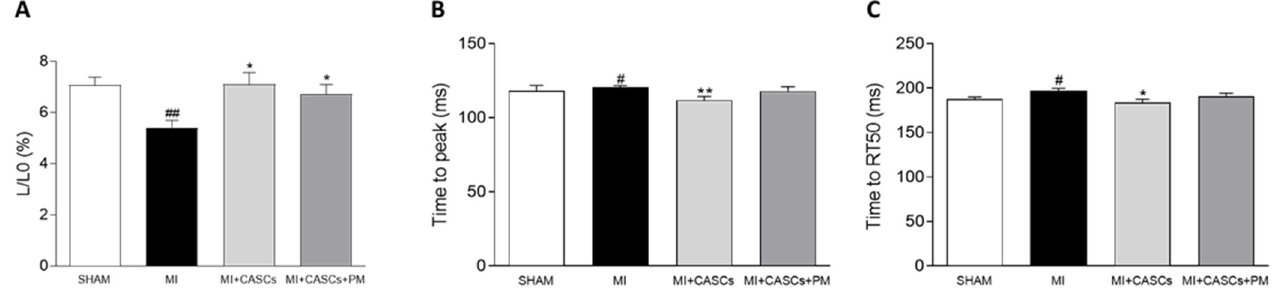
Figure 4. Resident cardiomyocyte shortening during field stimulation at 4 Hz. Quantification of ( A ) unloaded cell shortening normalized to diastolic cell length (L/L 0 ), ( B ) time to peak of contraction (TTP), and ( C ) time to half-maximal relaxation (RT 50 ) of resident cardiomyocytes from SHAM ( n cells = 80; n animals = 7), MI ( n cells = 60; n animals = 5), MI + CASCs ( n cells = 41; n animals = 4), and MI + CASCs + PM ( n cells = 31; n animals = 3). Data are expressed as mean ± SEM. * denotes p < 0.05; ** denotes p < 0.01 vs. MI, # denotes p < 0.05 vs. SHAM, and ## denotes p < 0.01 vs. SHAM.